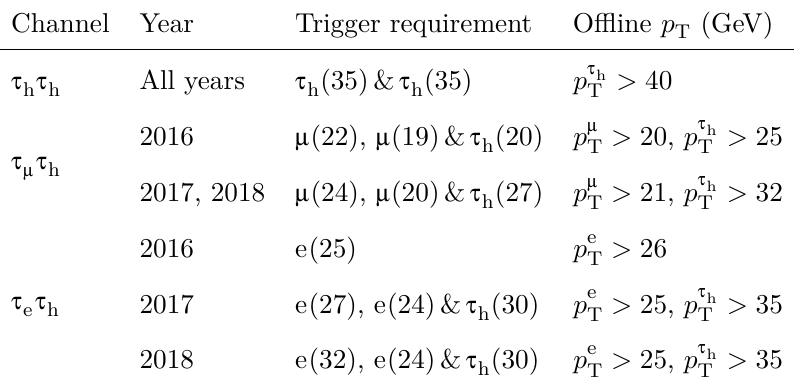
Table 2 . Kinematic trigger and offline requirements applied to the t The trigger p requirement is indicated in parentheses (in GeV). The p T the t apply only for the object matched to the hadronic trigger or to the hadronic leg from the h cross